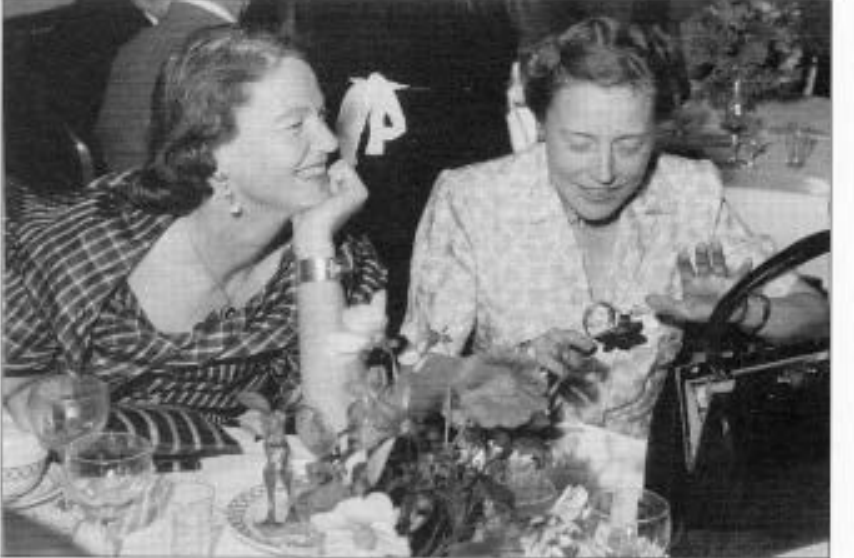
Figure 1 Nancy Sandars (left) with a Swiss colleague at the conference dinner during the third congress of the Union Internationale des Sciences Pn§historiques et Protohis­ toriques (UISPP) in Zurich, August